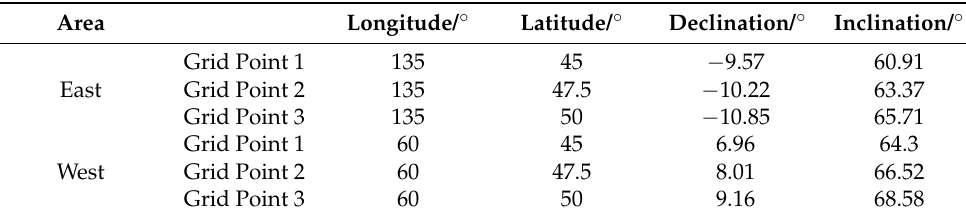
Table 1. Geographic longitude, latitude and magnetic declination/inclination of the chosen GIMs grid